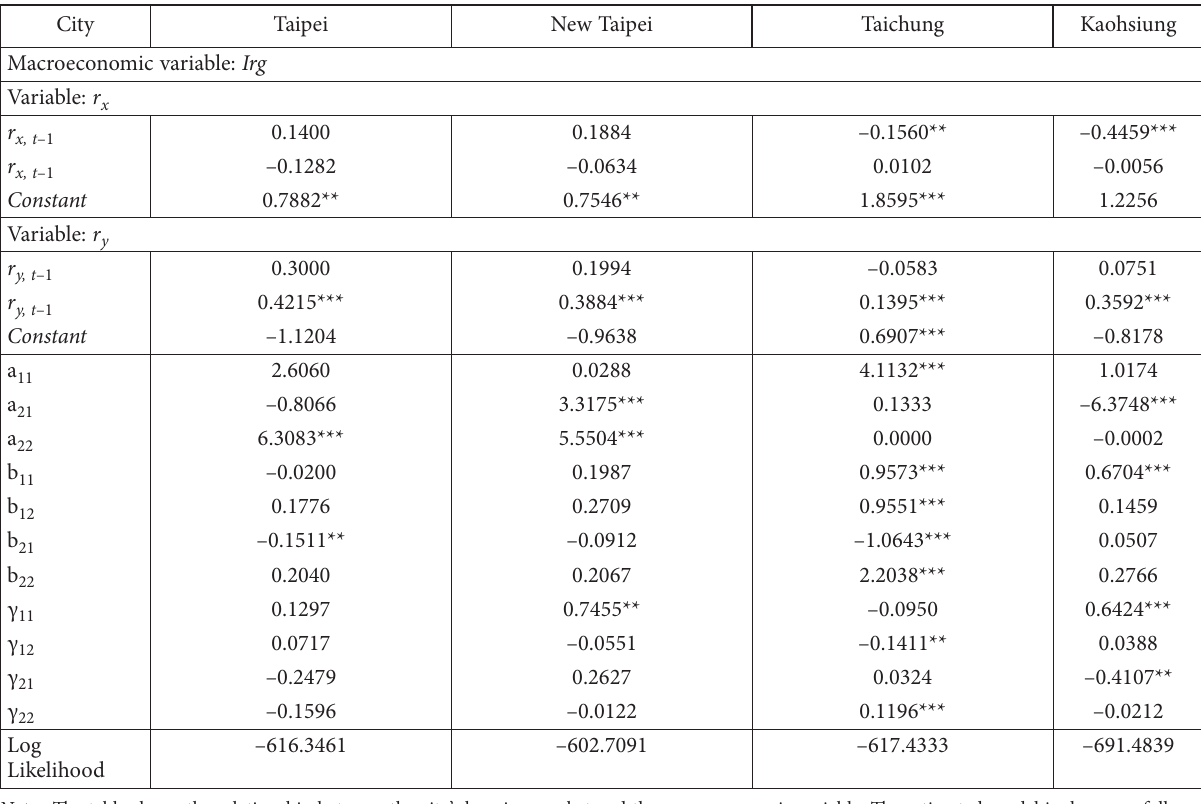
Table 8. VAR-GARCH models of interest rate and the housing